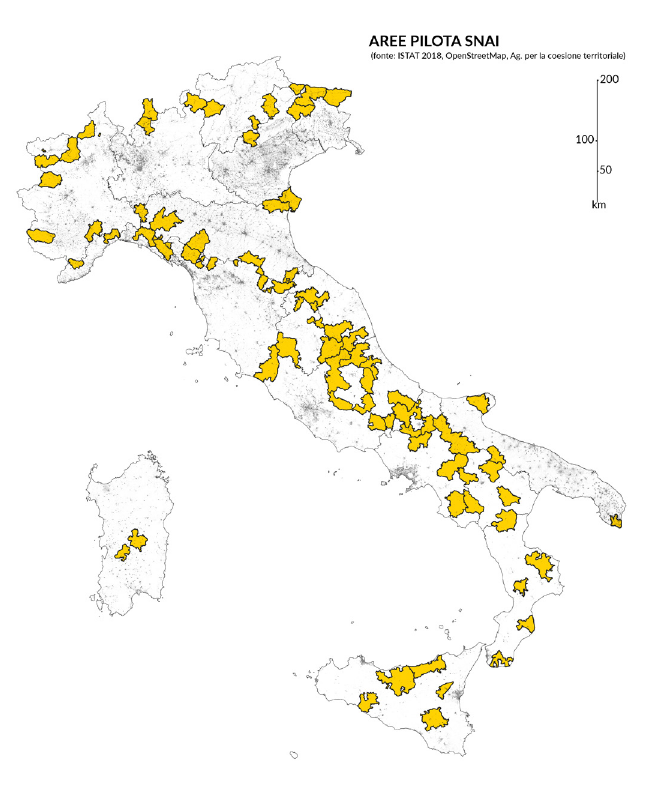
Fig. 2 Marco Vedoà, The 72 experimental areas identified by